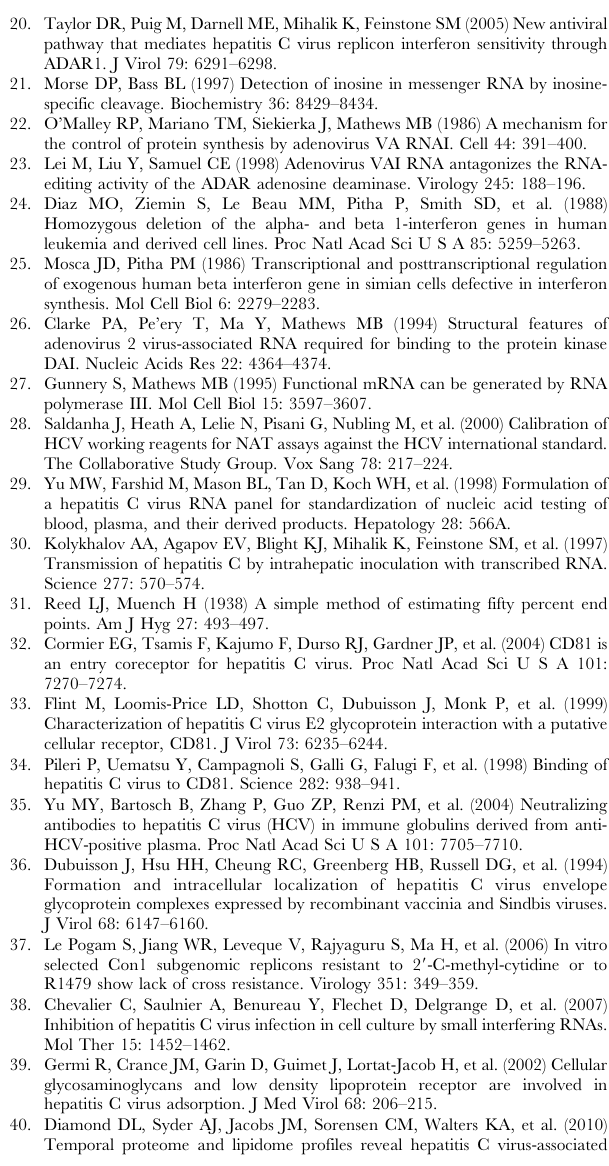
Table S1 HCV genotype 1a replicates in hepatic and non- hepatic cells transfected with VA RNA I